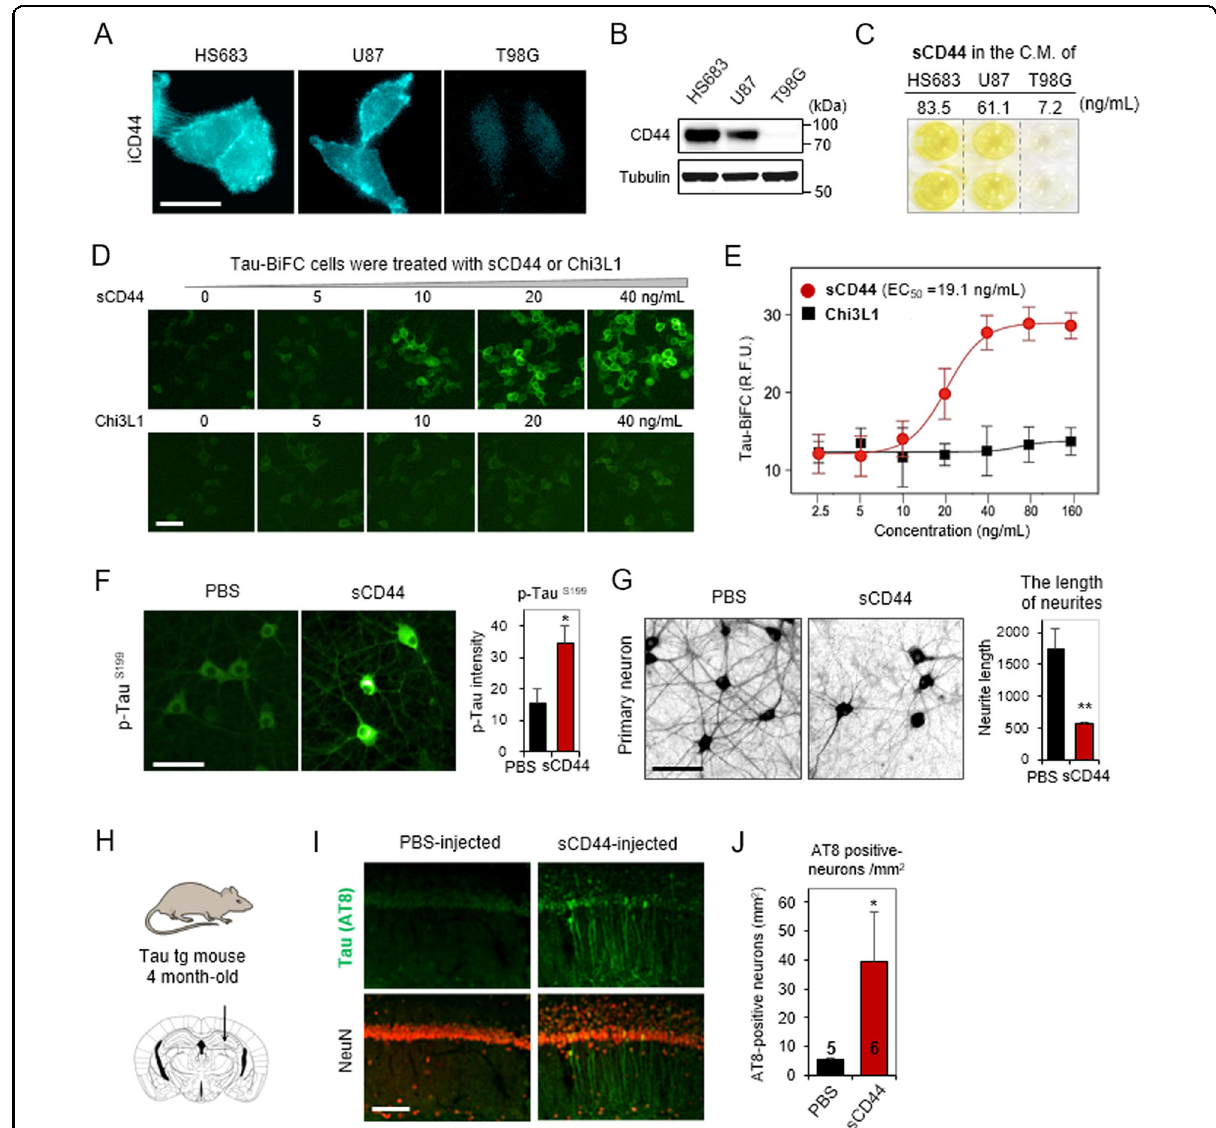
Fig. 4 sCD44 induces tau phosphorylation and aggregation. a CD44-immuno fl uorescence images of HS683, U87, and T98G cells. Cells were fi xed and stained with anti-intracellular CD44 (iCD44) antibody. Scale bar, 50 µm. b CD44 immuno-blot analysis. HS683, U87, and T98G cell lysates were prepared and analyzed with anti-iCD44 or anti-tubulin antibodies. c sCD44 levels in HS683-, U87-, and T98G-C.M. were quanti fi ed by using a human sCD44 ELISA assay. Experiments were performed in duplicate. d Tau-BiFC responses upon the treatment of sCD44 or Chi3L1 at various concentration. Scale bar, 100 µm. e Quanti fi cation of tau-BiFC- fl uorescence intensity. A Prism ’ s non-linear regression analysis was used to measure the EC 50 value. The EC 50 of sCD44 is 19.1 ng/mL. f Tau-immuno fl uorescence images of primary hippocampal neurons upon the treatment of sCD44. Rat embryonic hippocampal neurons were treated with sCD44 protein (120ng/mL) at 7 days in vitro and incubated for 48 h. Scale bar, 100 µm. p-Tau (Ser199) intensity was measured by using a Harmony 3.1 software. * p < 0.05. g Live hippocampal neurons stained with NeuO 21 . After 48 h of sCD44 (120ng/mL) treatment, hippocampal neurons were stained with NeuO and imaged. The maximal length of neurites was quanti fi ed by the Harmony 3.1 software. Scale bar, 100 µm. Error bars represent the standard deviation of three independent experiments. ** p < 0.01. h sCD44 was stereotaxically injected to the hippocampus of 4-month-old tau transgenic (MAPT*P301L) mice ( n = 6). i Experimental scheme of sCD44 injection to the hippocampus of 4-month-old tau transgenic (MAPT*P301L) mice ( n = 6). Scale bar, 50 µm. j A number of AT8-positive neurons was calculated in the hippocampal region (cells/mm 2 ) of the sCD44- ( n = 6) or PBS-injected ( n = 5) mice brain tissues. The signi fi cance of the experiments was determined by Student ’ s t -test. * p <